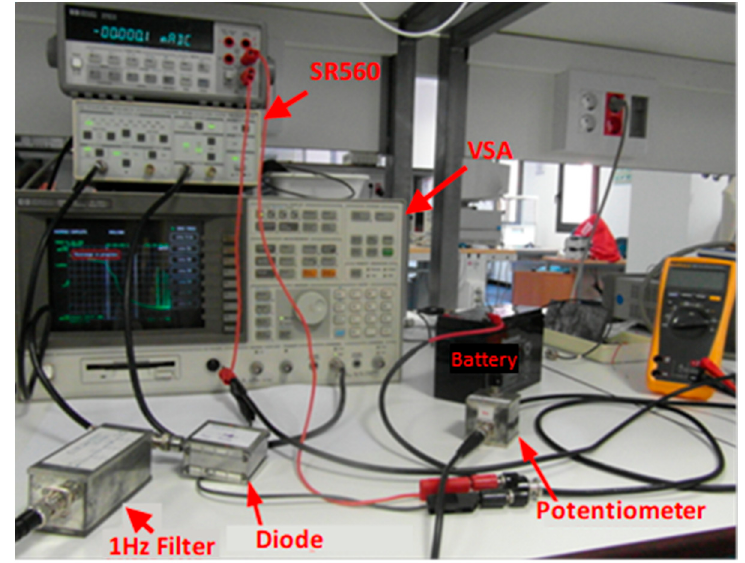
Figure 13. Setup to evaluate low-frequency noise under different DC biases.